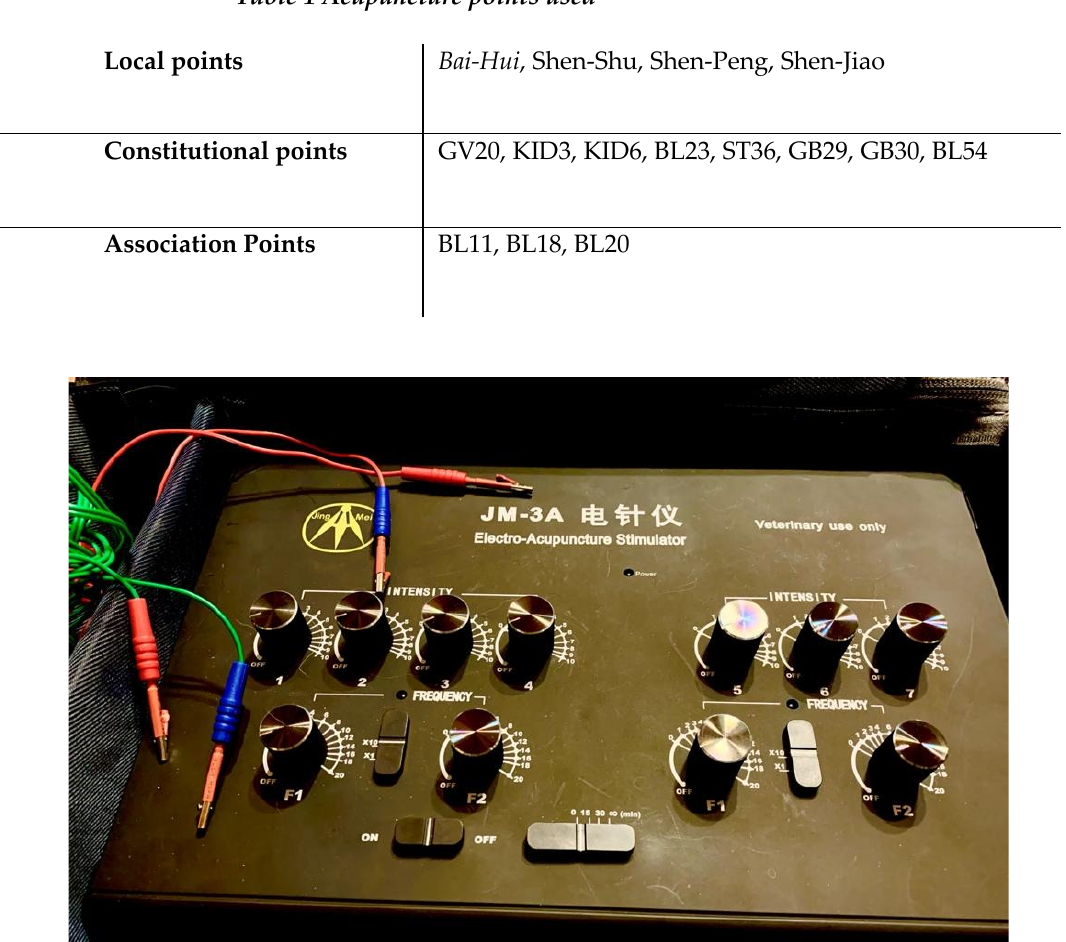
Table 1 Acupuncture points used